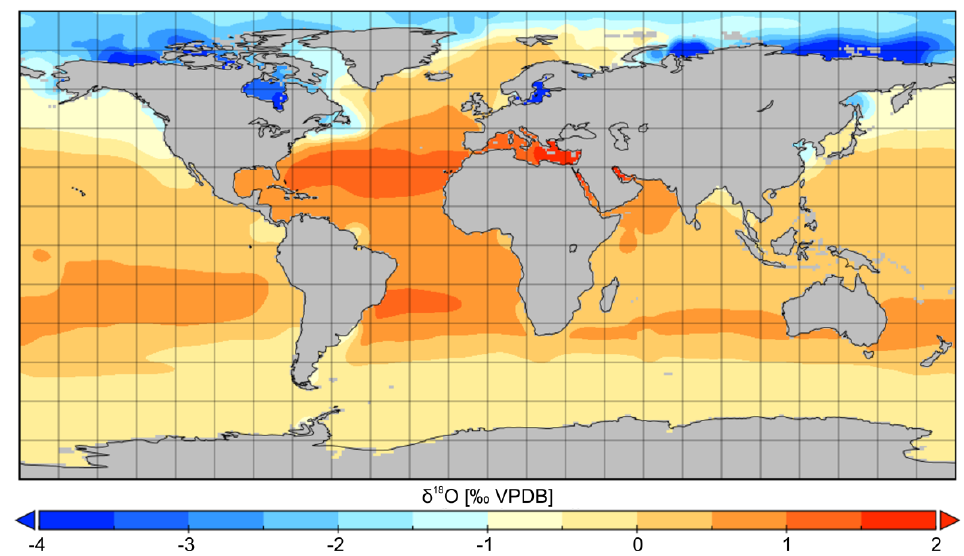
Figure 10. Gridded dataset of surface water δ 18 O values of modern oceans (after Schmidt et al. [269] and LeGrande and Schmidt [270]).